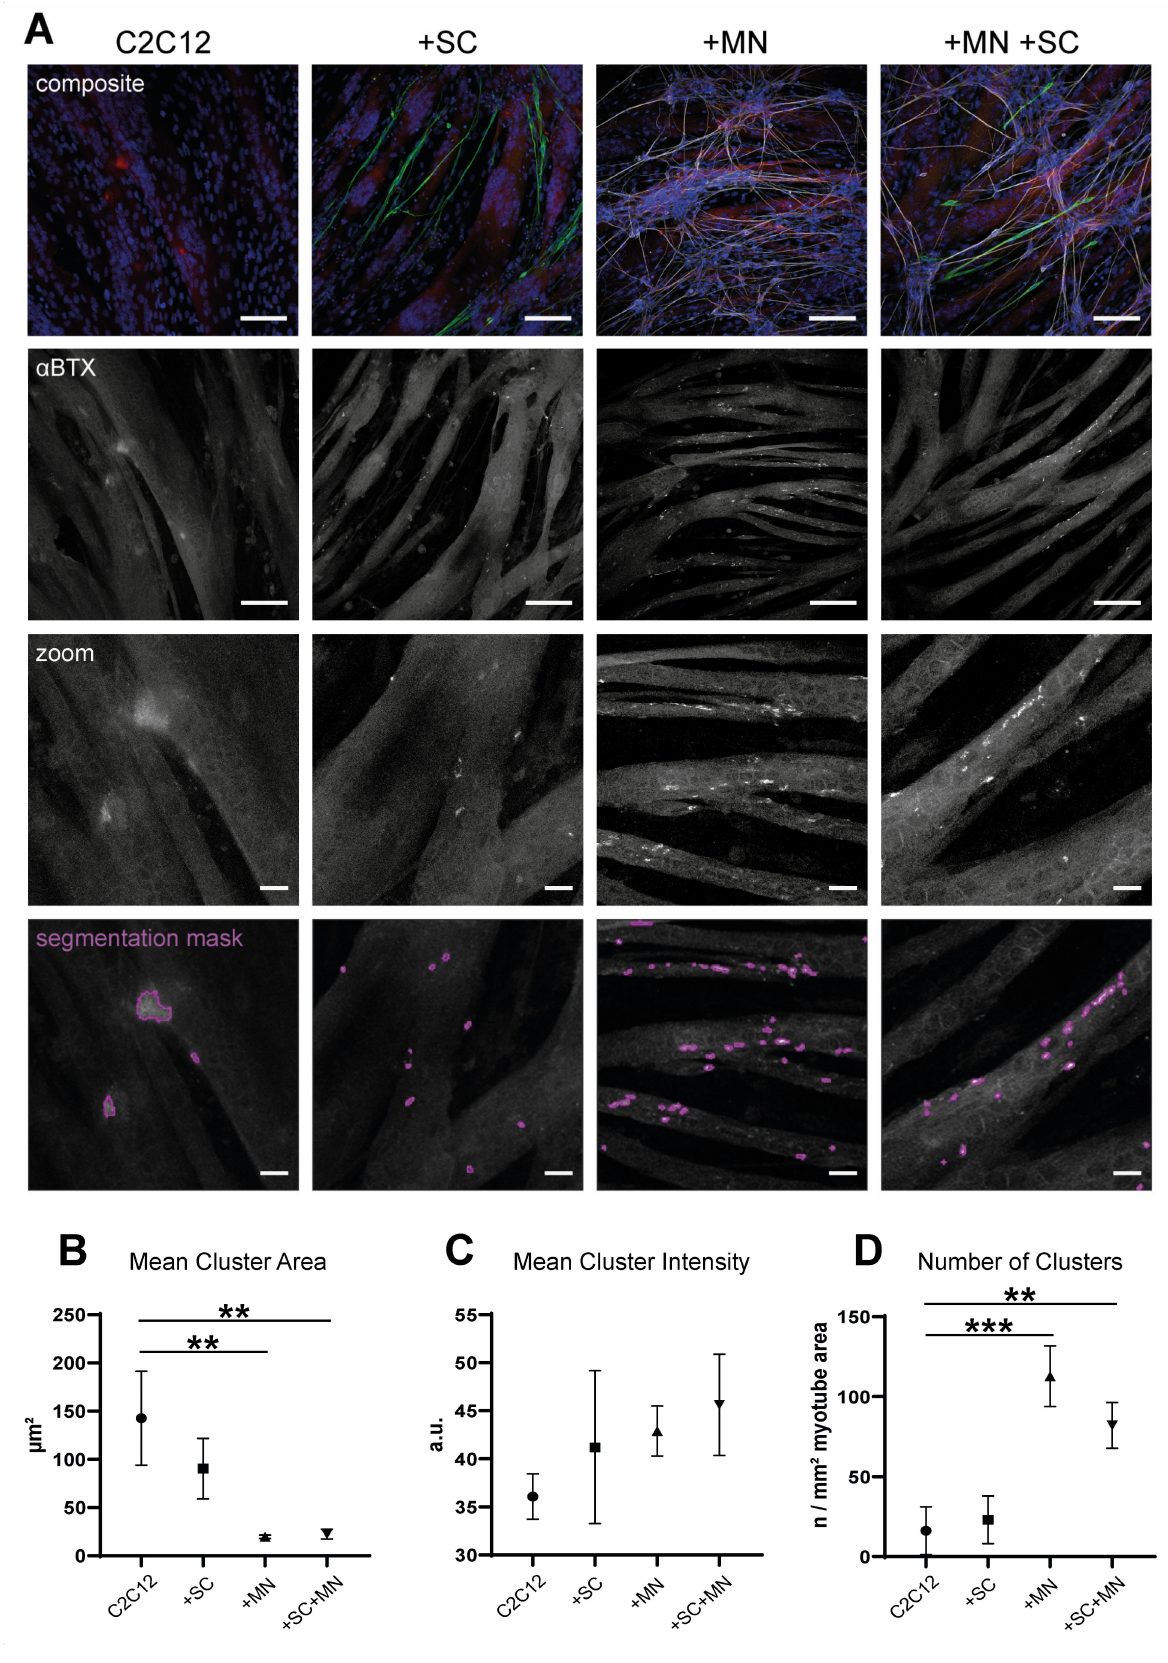
Figure 7. Cocultures with hiPSC motoneurons and Schwann cells influence formation of AChR clusters on C2C12 myotubes. C2C12 cells were cultured on cover slips for three days in the absence (C2C12) or presence of SC (+ SC),